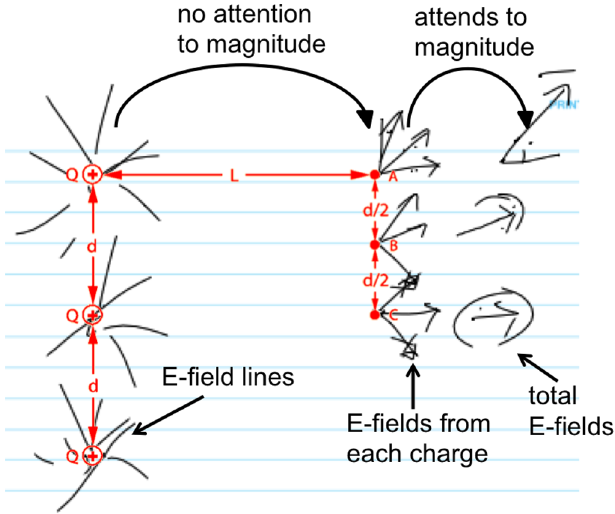
FIG. 3 (color online). Student drawing from interview. Portions of the picture in red are from the question statement which is reprinted with permission from Singh [41]. Dark gray is the student’s drawing, and explanation of the student’s drawing are black. After drawing electric field lines radiating outwards from each charge, the student drew three vectors of equal magnitude at each measurement point—one for the contribution to the electric field from each charge. At this point he does not attend to the magnitude of the vectors. To the right of that the student then drew the sum of those vectors as the total electric field. In this stage he attends to the magnitude of the